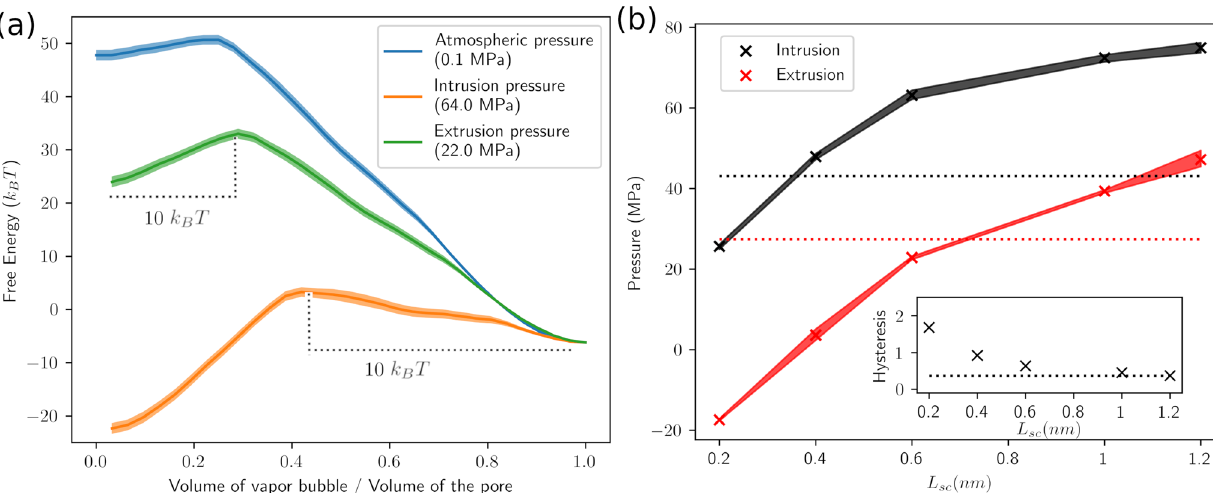
Fig. 3 Intrusion and extrusion pressures depend on the length of the secondary channels. a Free energy pro fi le of the system at the intrusion pressure (orange), extrusion pressure (green), and atmospheric pressure (blue) for secondary channel length, L sc = 0.6 nm. Pressurizing the system amounts to tilting the free energy pro fi le. We highlight the intrusion and extrusion barriers that would allow to observe these events in typical experimental timescales, i.e., approximately milliseconds. b Intrusion (black) and extrusion (red) pressures as a function of the length of the secondary channels. The intrusion and extrusion pressures for the system without secondary channels are reported for comparison (dotted lines). The inset shows pressure hysteresis, H = ( p − p p p p i nt , with int ext )/ int and ext being the intrusion and extrusion pressure, respectively, as a function of